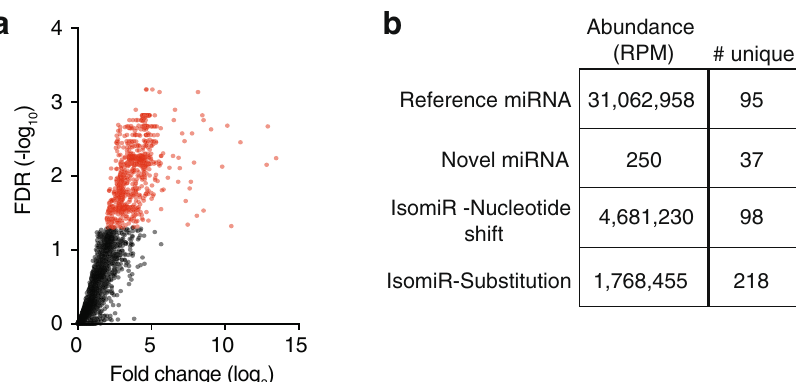
Fig. 5 Discovery and detection of non-reference miRNAs. a Volcano plot showing all non-reference miRNAs enriched (log 2 fold change > 2, FDR < 0.05 relative to wild type). b Table showing abundance (reads per million, RPM) and number of unique sequences (# unique) which make up each class of reference miRNA, novel candidate miRNA or isomiR (nucleotide shift or substitution).